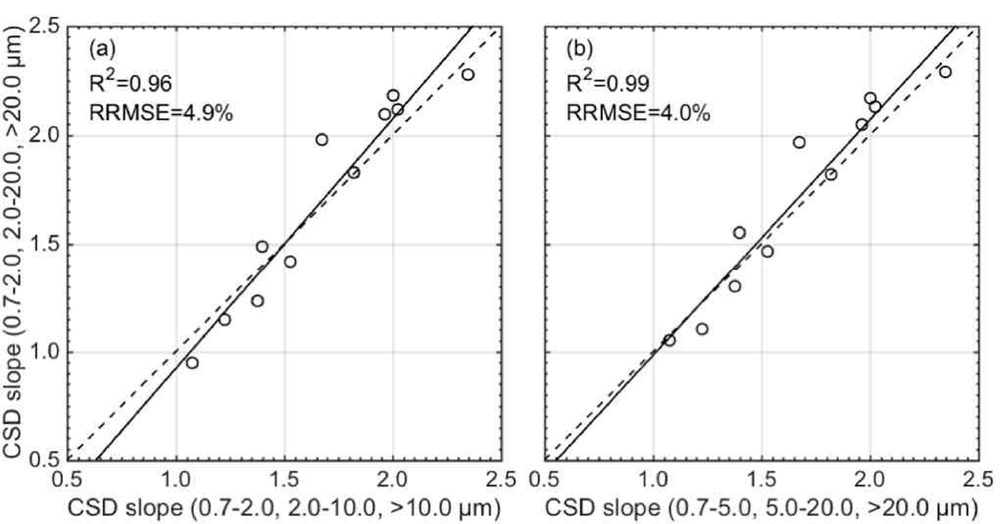
Figure 2. The comparison of CSD slope derived from three typical Chl a size which were divided by the filters of 0.7, 2.0 and 20 µ m pore size, and two different combinations of Chl a size : ( a ) Chl a size divided by the filters of 0.7, 2.0 and 10 µ m pore size; and ( b ) 0.7, 5.0 and 20 µ m pore size. Solid and dashed lined represent the 1:1 agreements and regression lines, respectively.